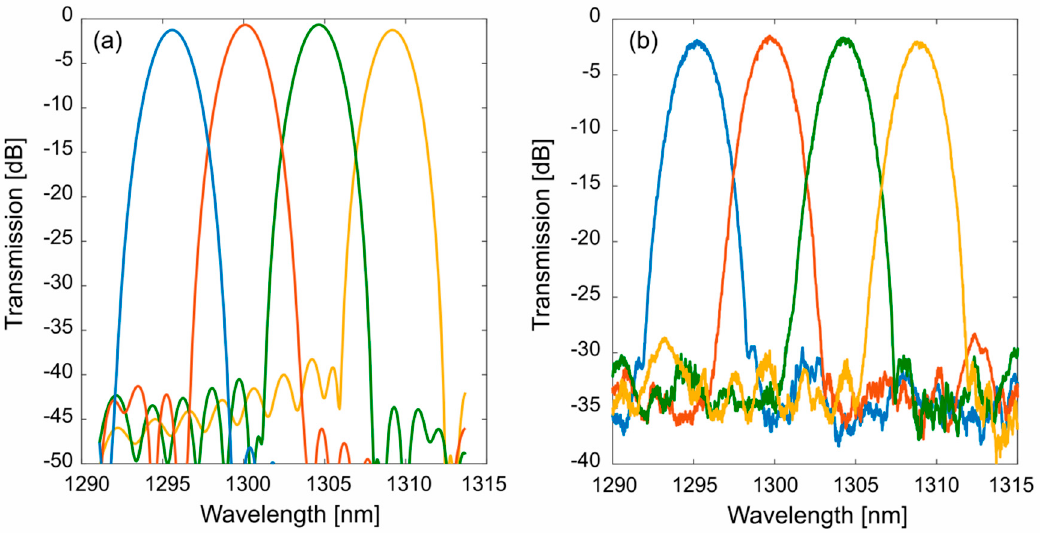
Figure 2. ( a ) Simulated and ( b ) experimental transmission spectra for the four channels of the echelle demultiplexer. Measured insertion losses are − 1.5 dB with channel uniformity (roll-off) less than 0.5 dB. Crosstalk is below − 28.3 dB for all channels.